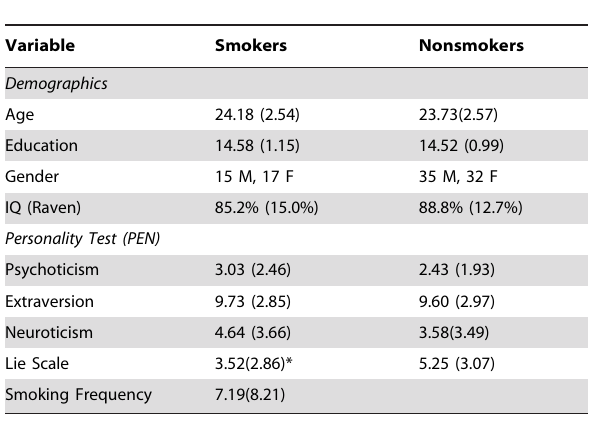
Table 3. Demographic and personality questionnaire data for smokers and nonsmokers, and the average number of cigarettes smoked per day in the last six months in the smokers group (standard deviations appear in